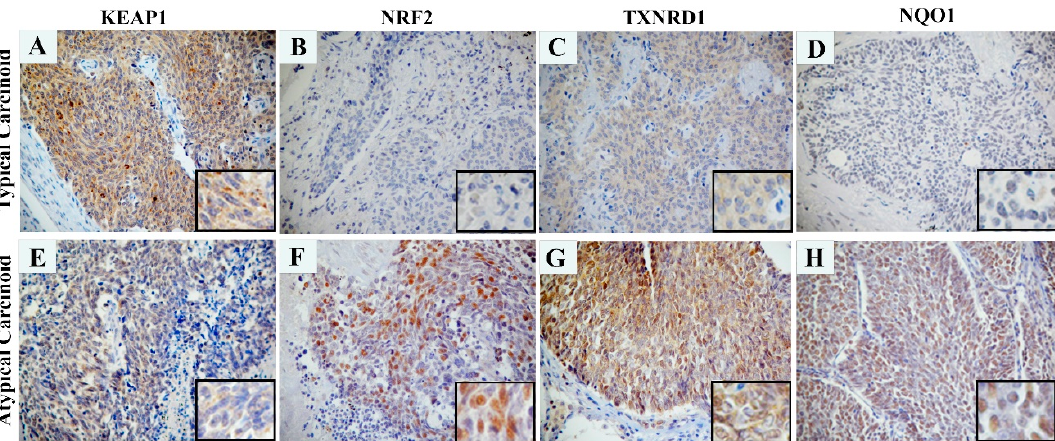
Figure 4. Immunohistochemistry analysis showing KEAP1, NRF2, TXNRD1 and NQO1 proteins expression in one typical (unmethylated, A – D ) and one atypical (methylated, E – H ) lung tissue from two different carcinoid affected patients. 20× and 40× magnification. A strong KEAP1 cytoplasmatic staining was observed in a typical unmethylated lung carcinoid tissue with a mild nuclear NRF2 and cytoplasmatic TXNRD1 and NQO1 staining, whereas an inverse protein staining pattern was observed in an atypical methylated lung carcinoid tissue.